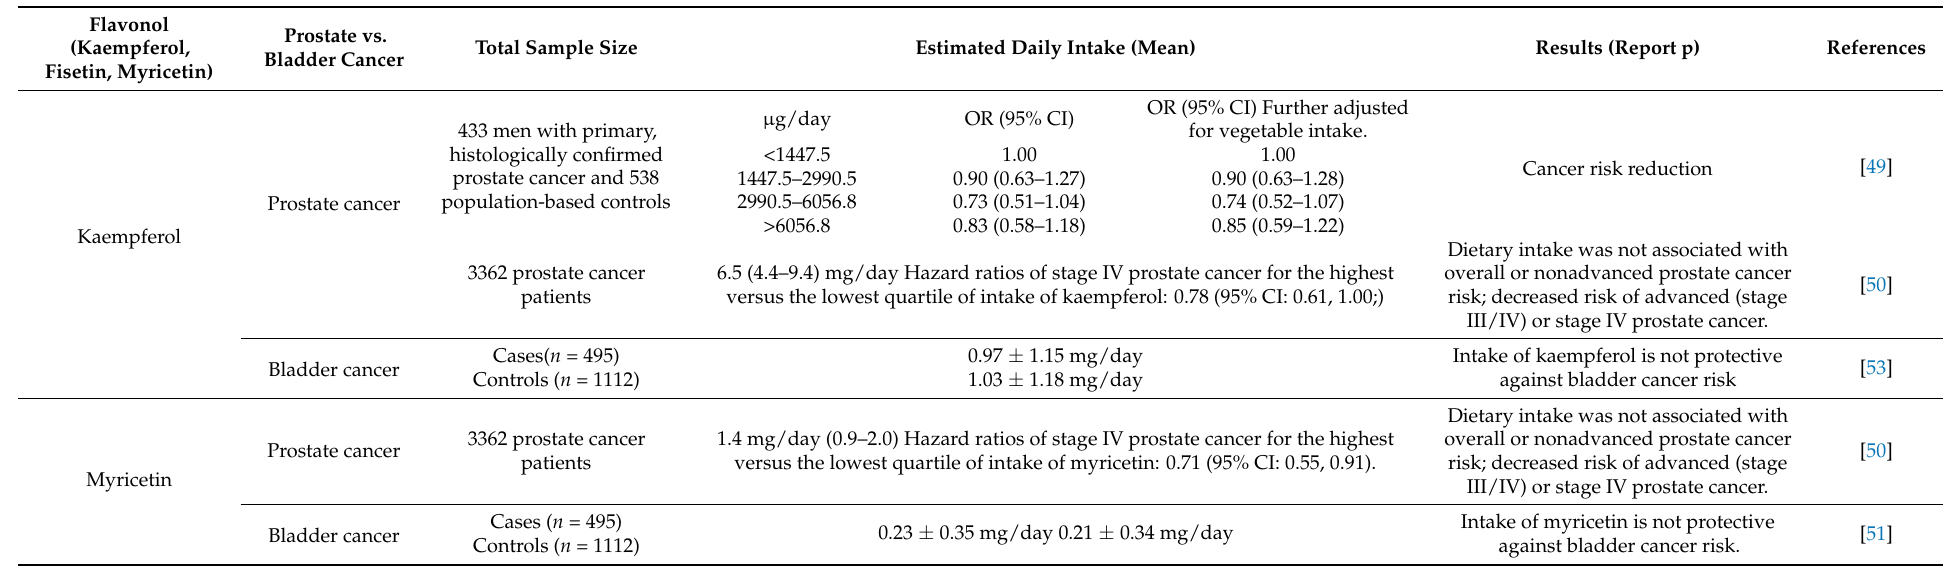
Table 4. Results of human